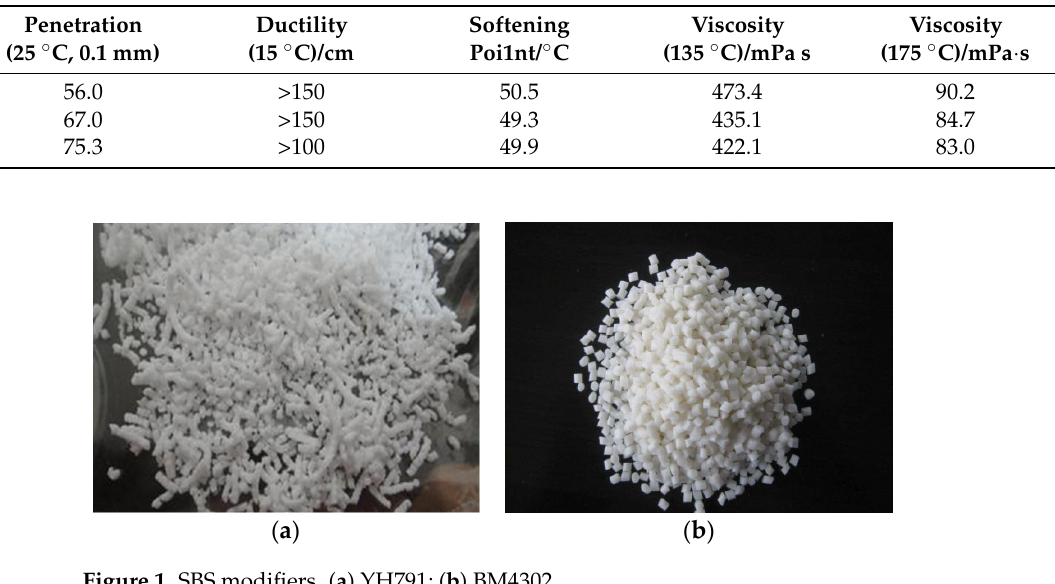
Figure 1. The SBS properties are shown in Table 2. The dosage of modifiers is 0, 2%, 3%, 4%, 5% and 6%, respectively. Table 1. Basic technical indicators of matrix asphalt. Table 1. Basic technical indicators of matrix asphalt.